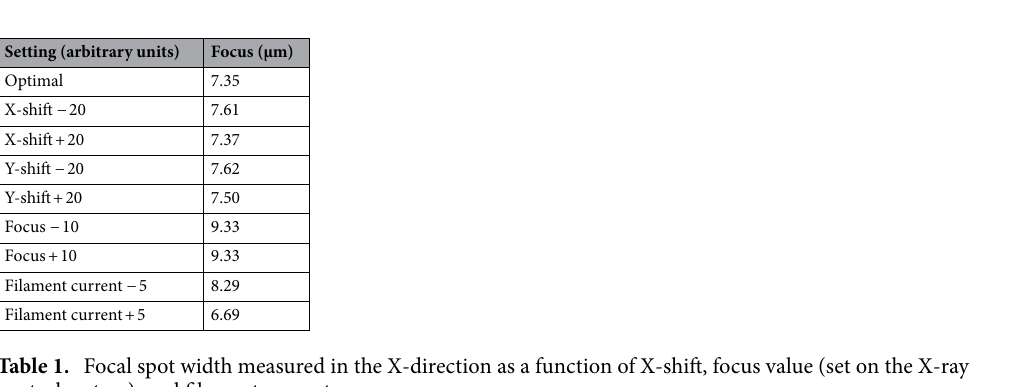
Table 1. Focal spot width measured in the X-direction as a function of X-shift, focus value (set on the X-ray control system), and filament current.